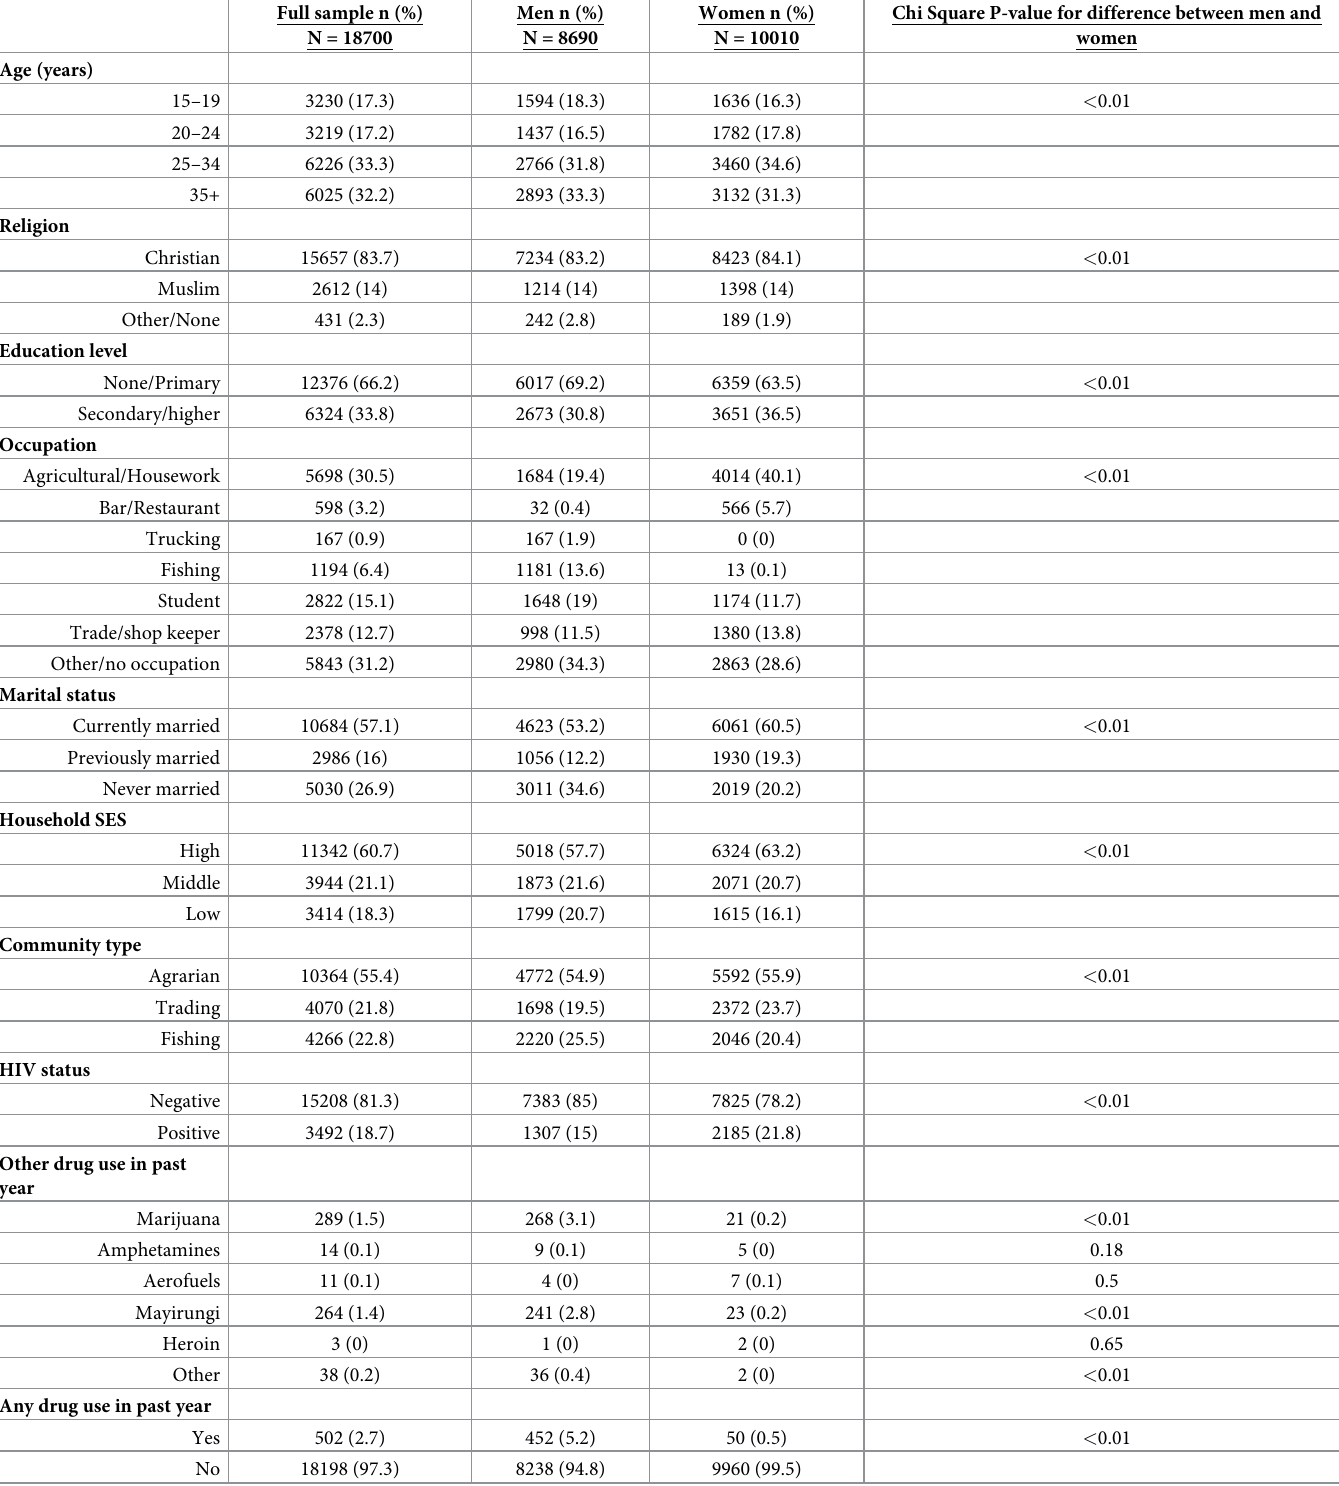
Table 1. Sociodemographic characteristics, past year drug use, HIV status, past year sexual activity and past year alcohol use and risk behaviors of men and women who participated in RCCS between March 2015 and September 2016 (N = 18,700), overall and by